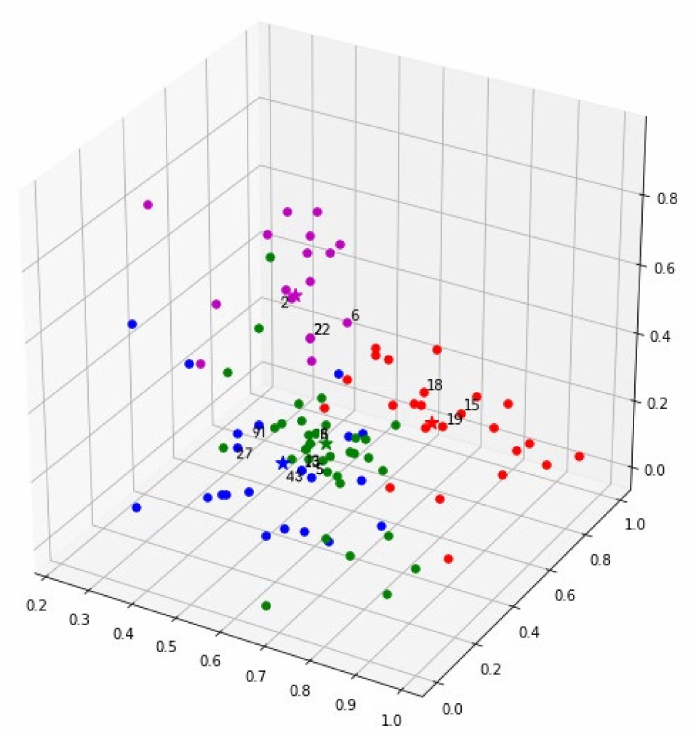
Figure 3. Results of cluster analysis of 100 healing commodities. Table 6. Information table about representative samples from four